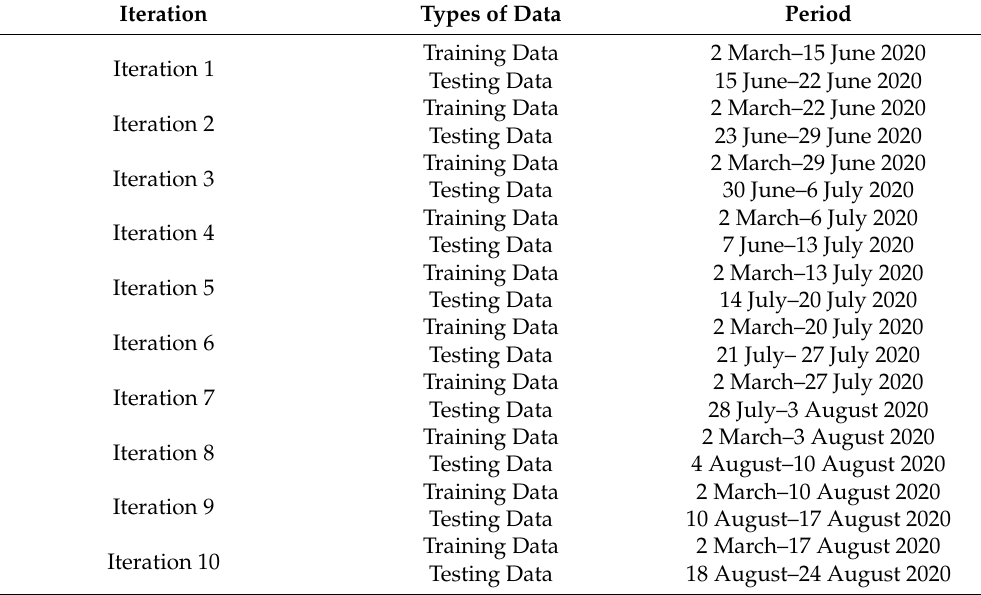
Table 4. Period for short-term testing